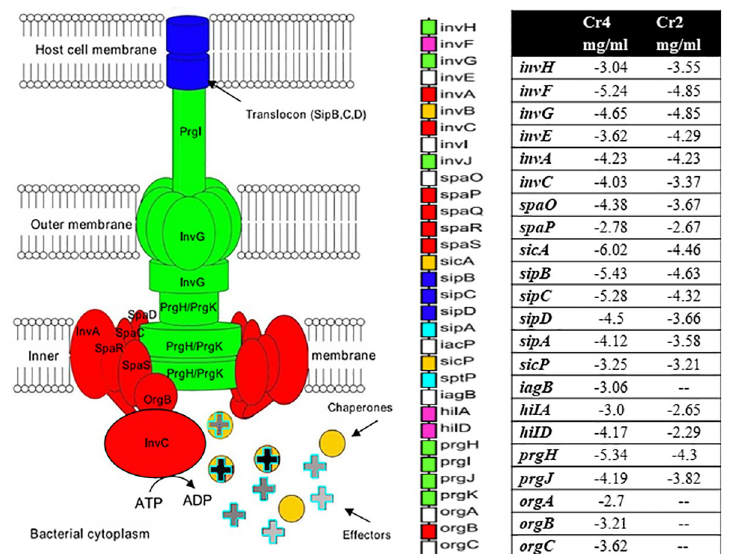
Fig 7. Schematic representation of SPI-1 island encoding the T3SS-1 proteins showing DEGs (in the chart) in response to KCOH. T3SS-1 is a supramolecular complexes that plays a major role in the virulence of Salmonella by injecting bacterial protein effectors directly into host cells (adopted from